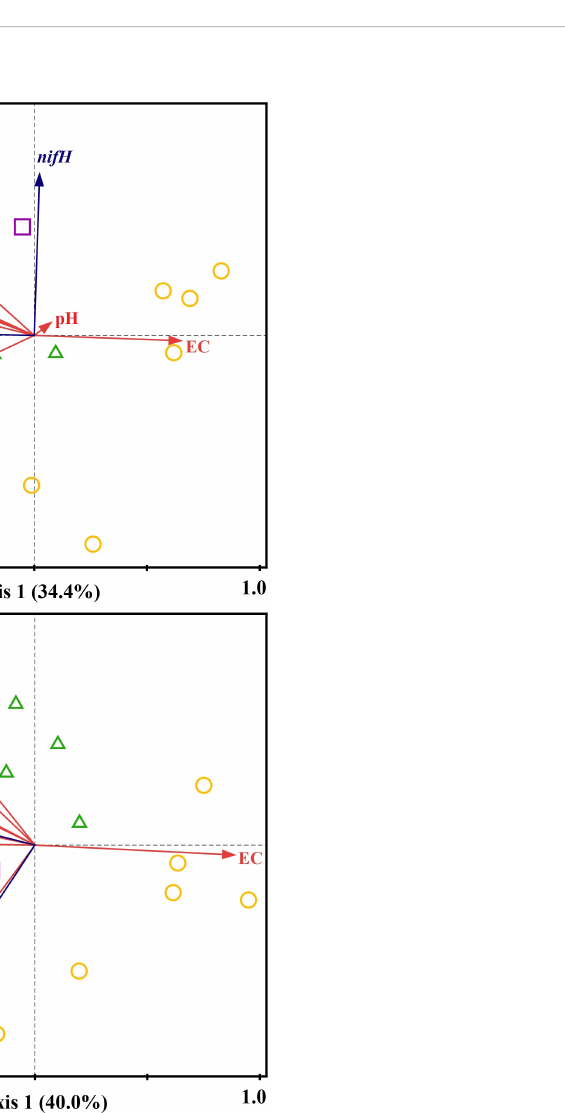
FIGURE 5 The redundancy analysis (RDA) of N fi xation rates (NFR) and nifH gene abundance with sediment parameters. The yellow circles, green triangles and purple squares represent natural saltmarsh, 5-year-old shrimp ponds and 18-year-old shrimp ponds in (A) summer and (B) winter,